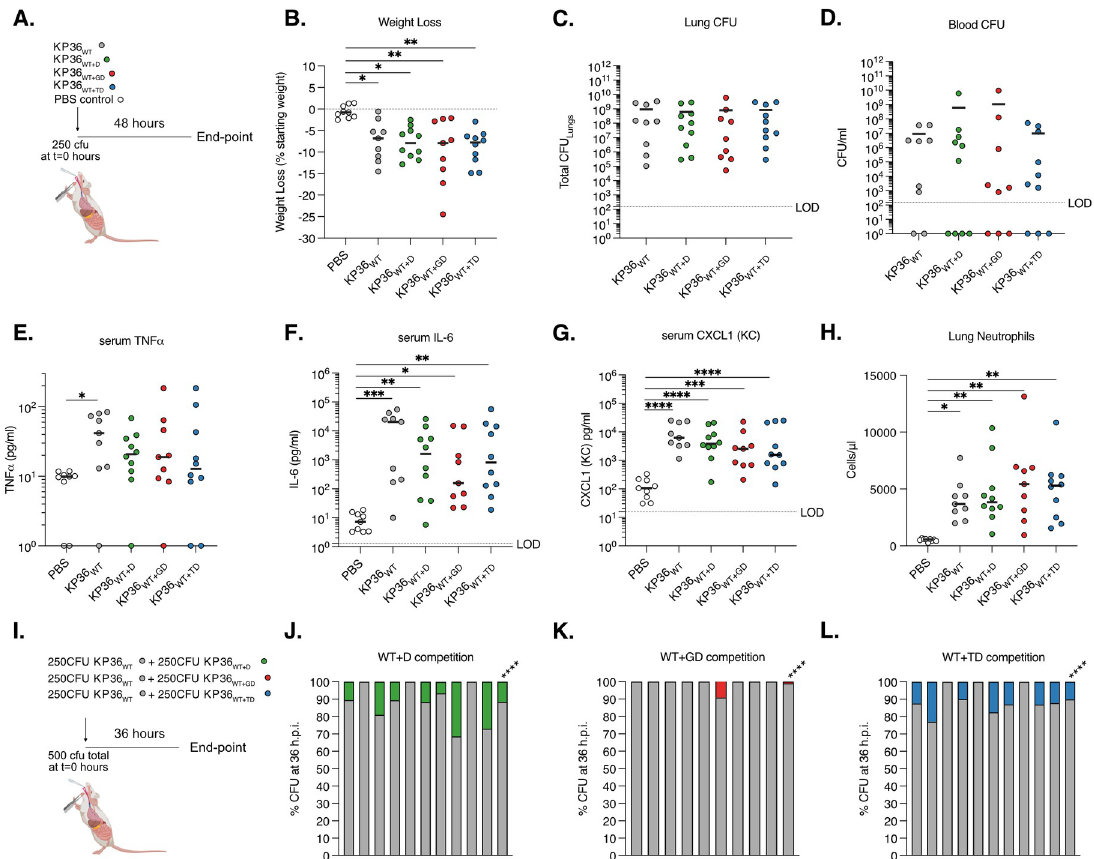
Fig 5. OmpK36 L3 insertions maintain virulence but confer a competitive disadvantage in a preclinical murine pneumonia model. A-H. Pneumonia was induced by the intratracheal administration of 250 CFU of isogenic KP strains expressing D (KP36 WT+D ), GD (KP36 WT+GD ) and TD (KP36 WT+TD ) OmpK36 L3 insertions. A strain lacking any L3 insertion (KP36 WT ) and PBS (uninfected) were used as controls. A schematic of the infection is outlined in panel A . At 48 hours post infection significant weight loss was induced by infection with all strains, irrespective of OmpK36 variant ( B) and no significant differences were observed between strains. No significant differences were observed in the lung ( C) and blood ( D ) bacterial burdens between infection with any strain. Serum TNF was only significantly increased following infection with KP36 WT compared to uninfected (PBS) controls ( E). Serum IL-6 ( F ), CXCL-1 ( G ) and lung neutrophils ( H ) significantly increased following infection with all strains compared to uninfected (PBS) controls, with no significant differences between strains observed. I-L. Competition assays were employed to stringently assess the fitness of OmpK36 L3 insertion mutations. A schematic of the infection is outlined in panel I. 250 CFU of KP36 WT was competed against 250 CFU of KP36 WT +D ( J ), KP36 WT+GD ( K ) or KP36 WT+TD ( L ) and bacterial burdens were assessed at 36 hours post infection in the lungs. Each graph shows the % CFU recovered in the lungs in individual mice followed by a summary bar with the mean competition result across infections. KP36 WT significantly outcompeted all the L3 insertions tested. � , p < 0.05; �� , p < 0.01; ��� , p < 0.001; ���� , p < 0.0001. All experiments were conducted in biological duplicate with 4–5 mice per group. B-H Significance was determined by ordinary one-way ANOVA followed by Tukey’s multiple comparison post-test, except in E where Kruskal-Wallis test was employed as data was not normally distributed. J-L Mean competition was assessed by Mann-Whitney T-test. The diagrams in A and I were created with